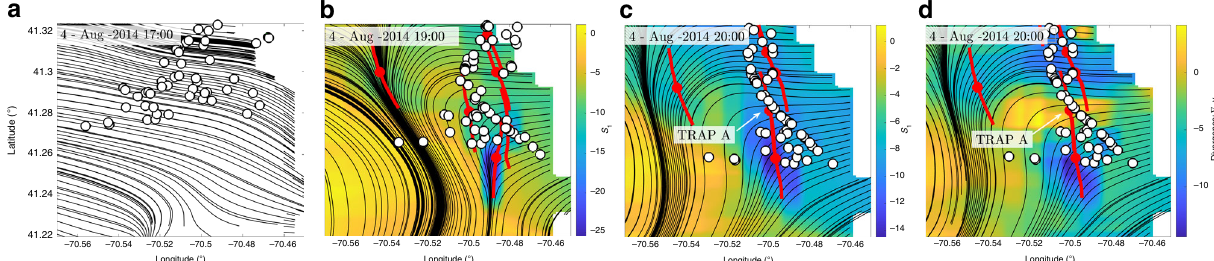
Fig. 4 2014 experiment. a Region bounded by the black rectangle in Fig. 3a showing drifter positions (white) at the beginning of our analysis (4 August 2014 at 17:00 EDT), along with the instantaneous streamlines (black) from HFR velocity. b and c TRAPs (red curves), whose normal attraction rate s 1 (the more negative the more attracting) is encoded in the colorbar, along with instantaneous streamlines and drifters' position, at 19:00 and 20:00 EDT. The time evolution of drifter positions along with TRAPs and velocity streamlines is available as Supplementary Movie 1. d Same as c with the colorbar encoding the horizontal divergence fi eld ( ∇ ⋅ v ). TRAP A in panels c and d strongly attracts the drifters despite being in a region of positive horizontal divergence. The colorbars unit is day − 1 .